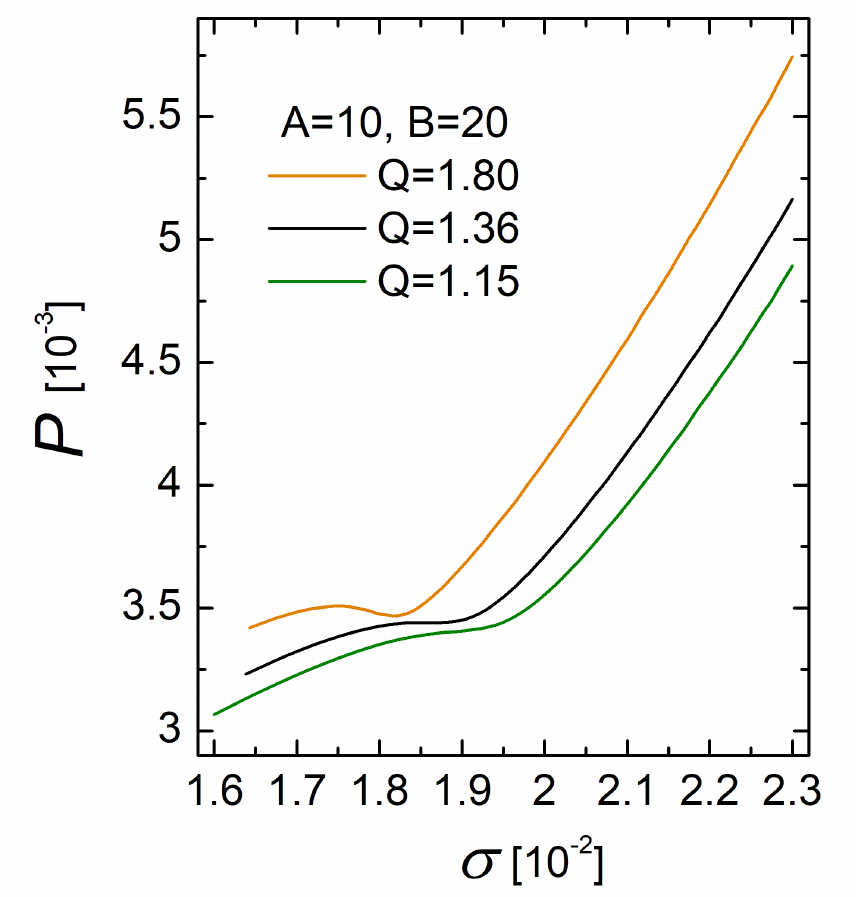
Figure 2. Equation of the state of dark matter at T = 0 and fixed parameters A and B . A slow growth in the dimensionless pressure P at a relatively low density σ corresponds to a dilute phase of matter, while a steep rise indicates a denser liquid-like phase at high densities. An orange curve (with two extrema) demonstrates the presence of metastable states. The black line is for a critical value of Q c = 1.36. The green line exemplifies a continuous transition between the two phases at Q < Q c